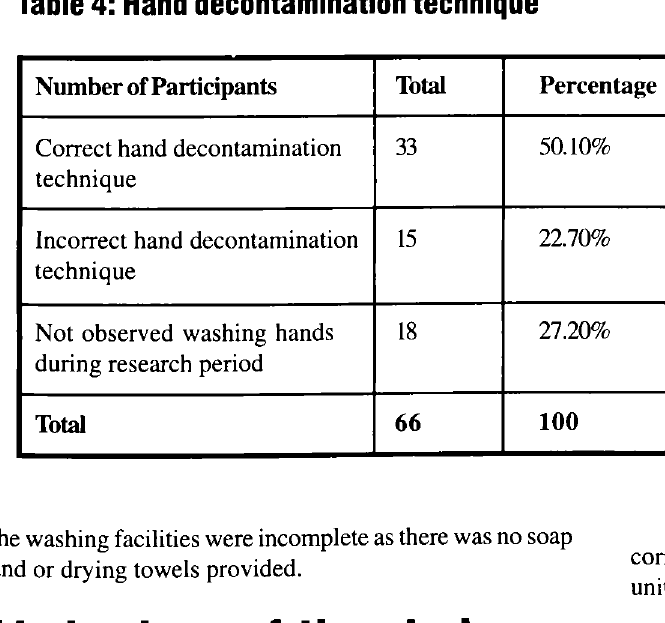
Table 4: Hand decontamination